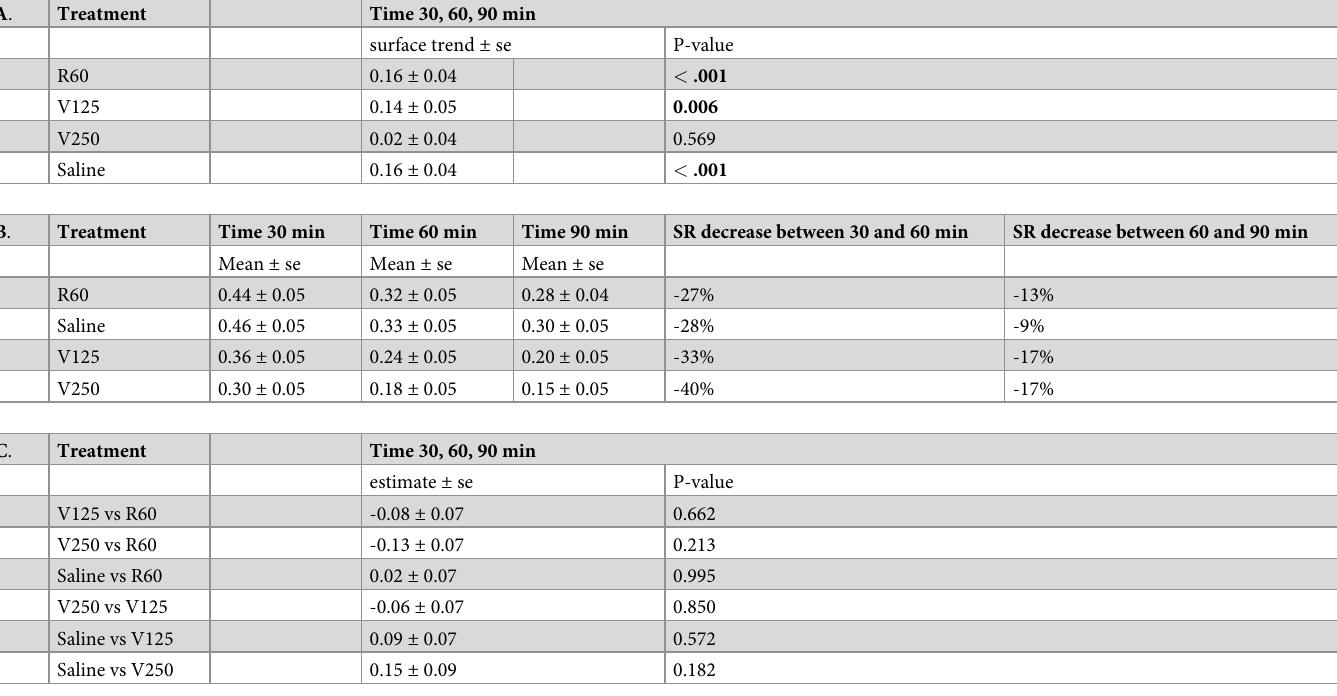
The model applied was (Secretion rate ~ surface � treatment + time + (1| locust) + (1+time|tubule)). ( A ) Estimates of the influence of each unit of surface (mm 2 ) on the fluid secretion rate for each treatment. ( B ) Summary of the mean values for each treatment at each time point. ( C ) Pairwise comparisons between treatments for each time of